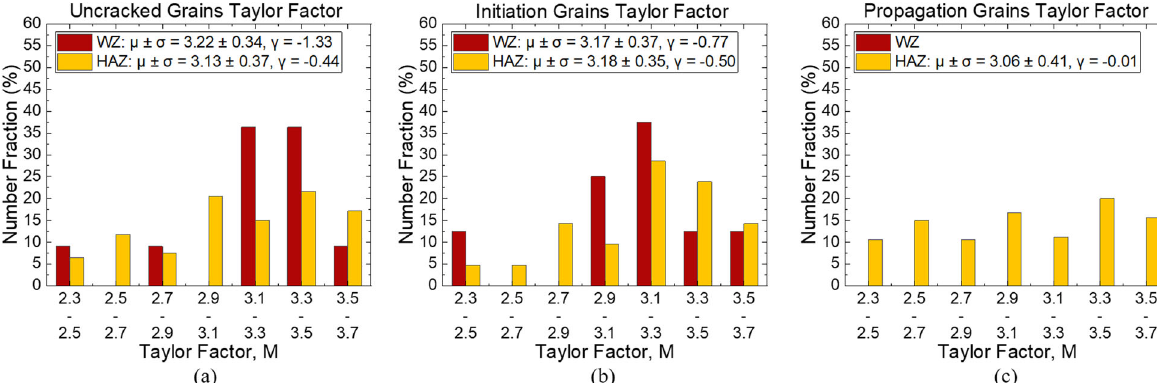
Fig. 5 Taylor factor distributions. a Uncracked surface grains; b surface initiation grains; c propagation grains along crack